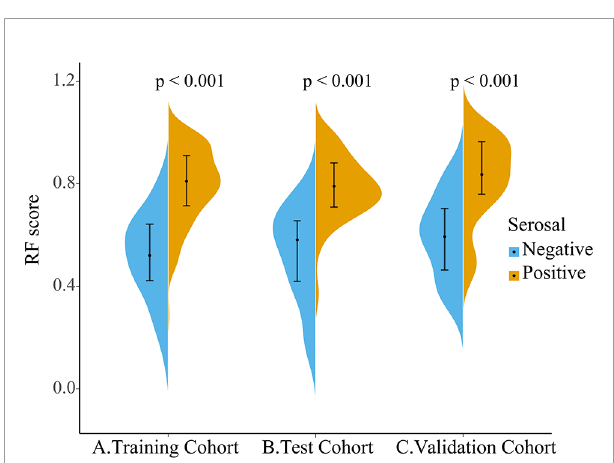
FIGURE 4 | Weights of the nine radiomics features in the radiomics model.